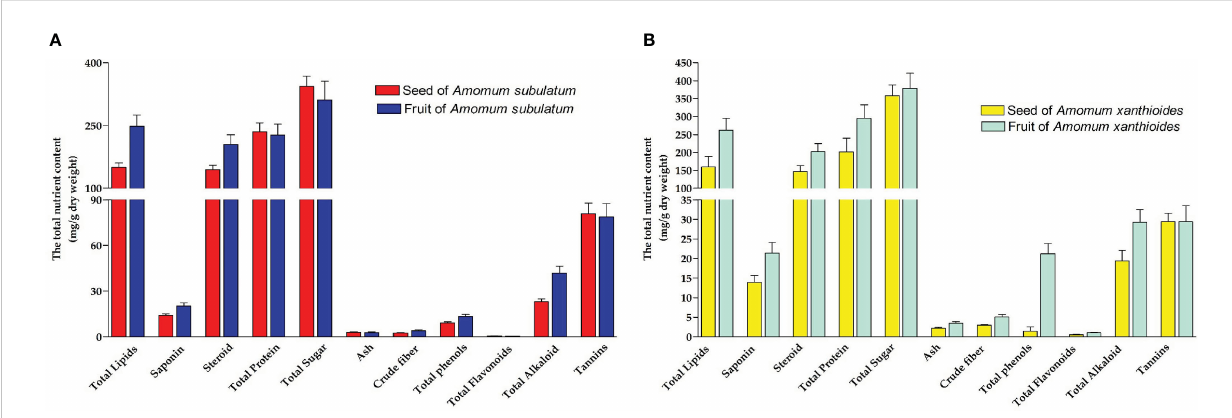
FIGURE 1 The total nutrient content (mg/g dry weight) in (A) seed and fruit of Amomum subulatum and (B) seed and fruit of Amomum xanthioides . The data are shown as the mean ± SEM of four plants per